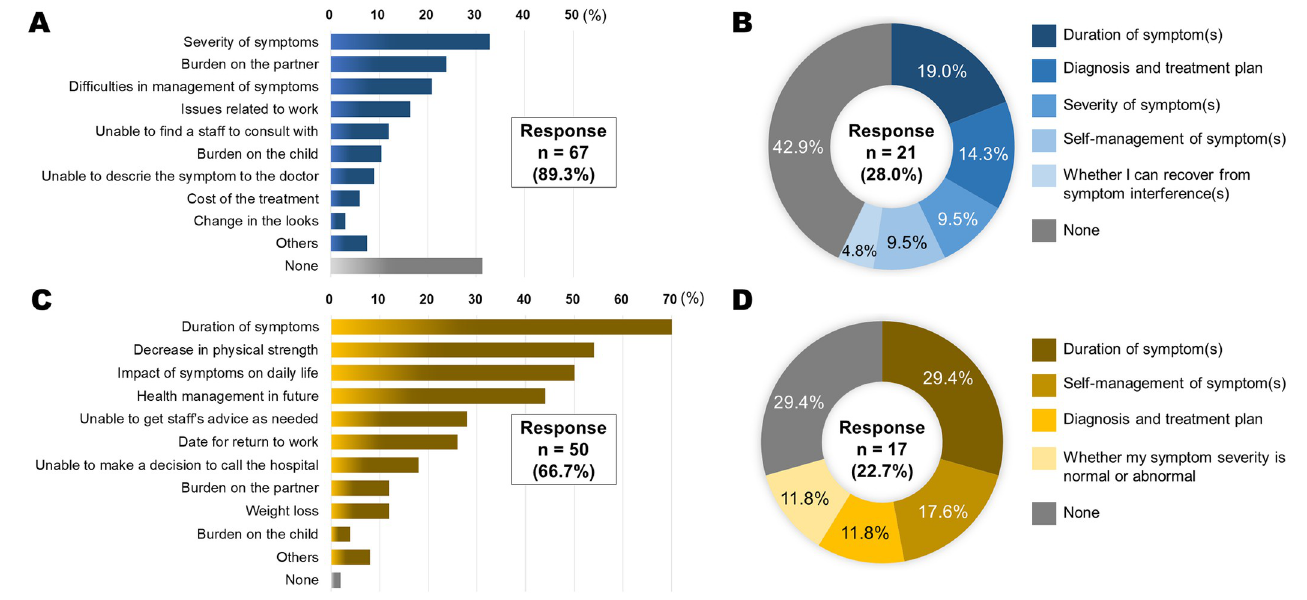
Fig 6. Reported patients’ distresses and information needs during hospitalization and after hospital discharge. A: Sixty-seven (89.3%) patients responded to the questionnaire for distress during the hospitalization; severity of symptoms, burden on the partner, and difficulties in management of symptoms were the three major distresses, accounting for 32.8%, 23.9%, and 20.9%. Of note, 31.3% of the questionnaire responses reported no distress during hospitalization. B: Twenty-one (28.0%) patients responded on concerning information needed during the hospitalization: duration of the symptoms was the leading concern accounting for 19.0% of participants. C: For distress after hospital discharge, 50 (66.7%) patients responded the questionnaire: duration of symptoms, decrease in physical strength, and impact of symptoms on daily life were the top three distresses, accounting for 70.0%, 54.0%, and 50.0%, respectively. No distress after hospital discharge was reported by only 8.0% of the patients responded the questionnaire. D: Seventeen (22.7%) patients responded the questionnaire on the information need after hospital discharge: duration of symptom was the leading concern accounting for 29.4%.